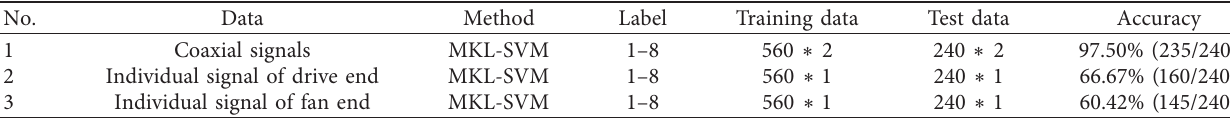
Table 6: Results of coaxial signals and individual signal.